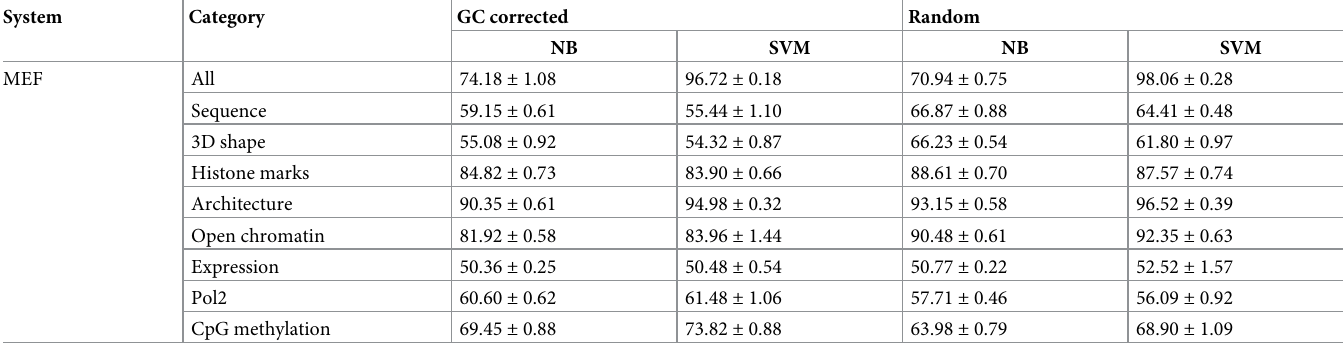
Table 1. Performance of SVM and NB classifiers in MEF.